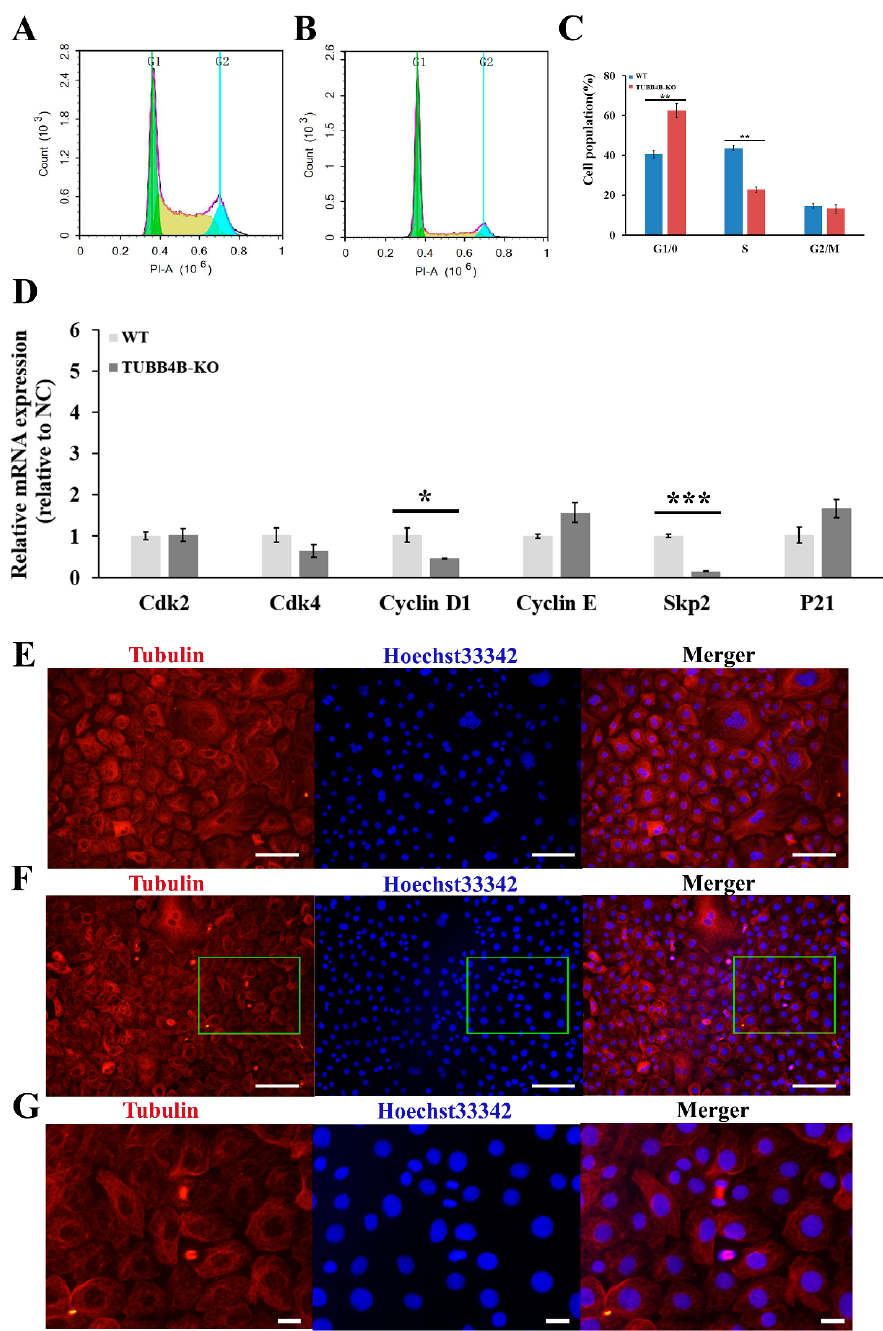
Tubb4b can inhibit the proliferation of mouse spermatogonia.